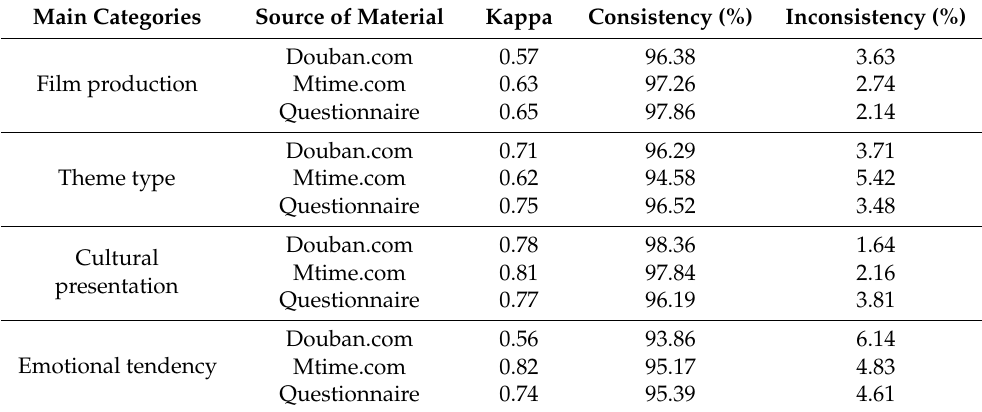
Table A1. Results of coding consistency